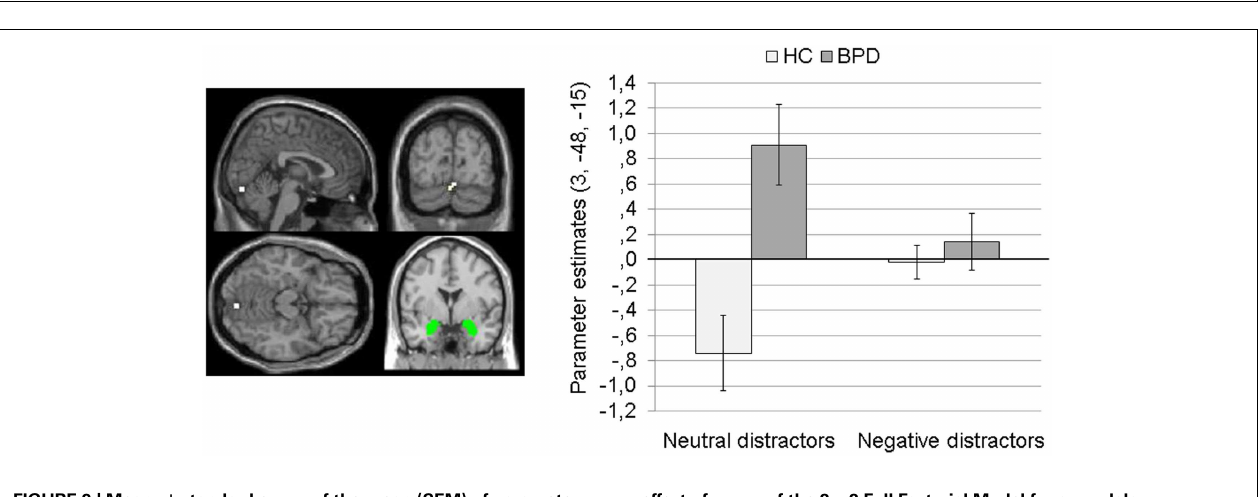
FIGURE 3 | Means ± standard errors of the mean (SEM) of parameter estimates for connectivity of the bilateral amygdala seed (depicted in green) with right lingual gyrus (MNI: 3, − 84, − 15) revealed by the main